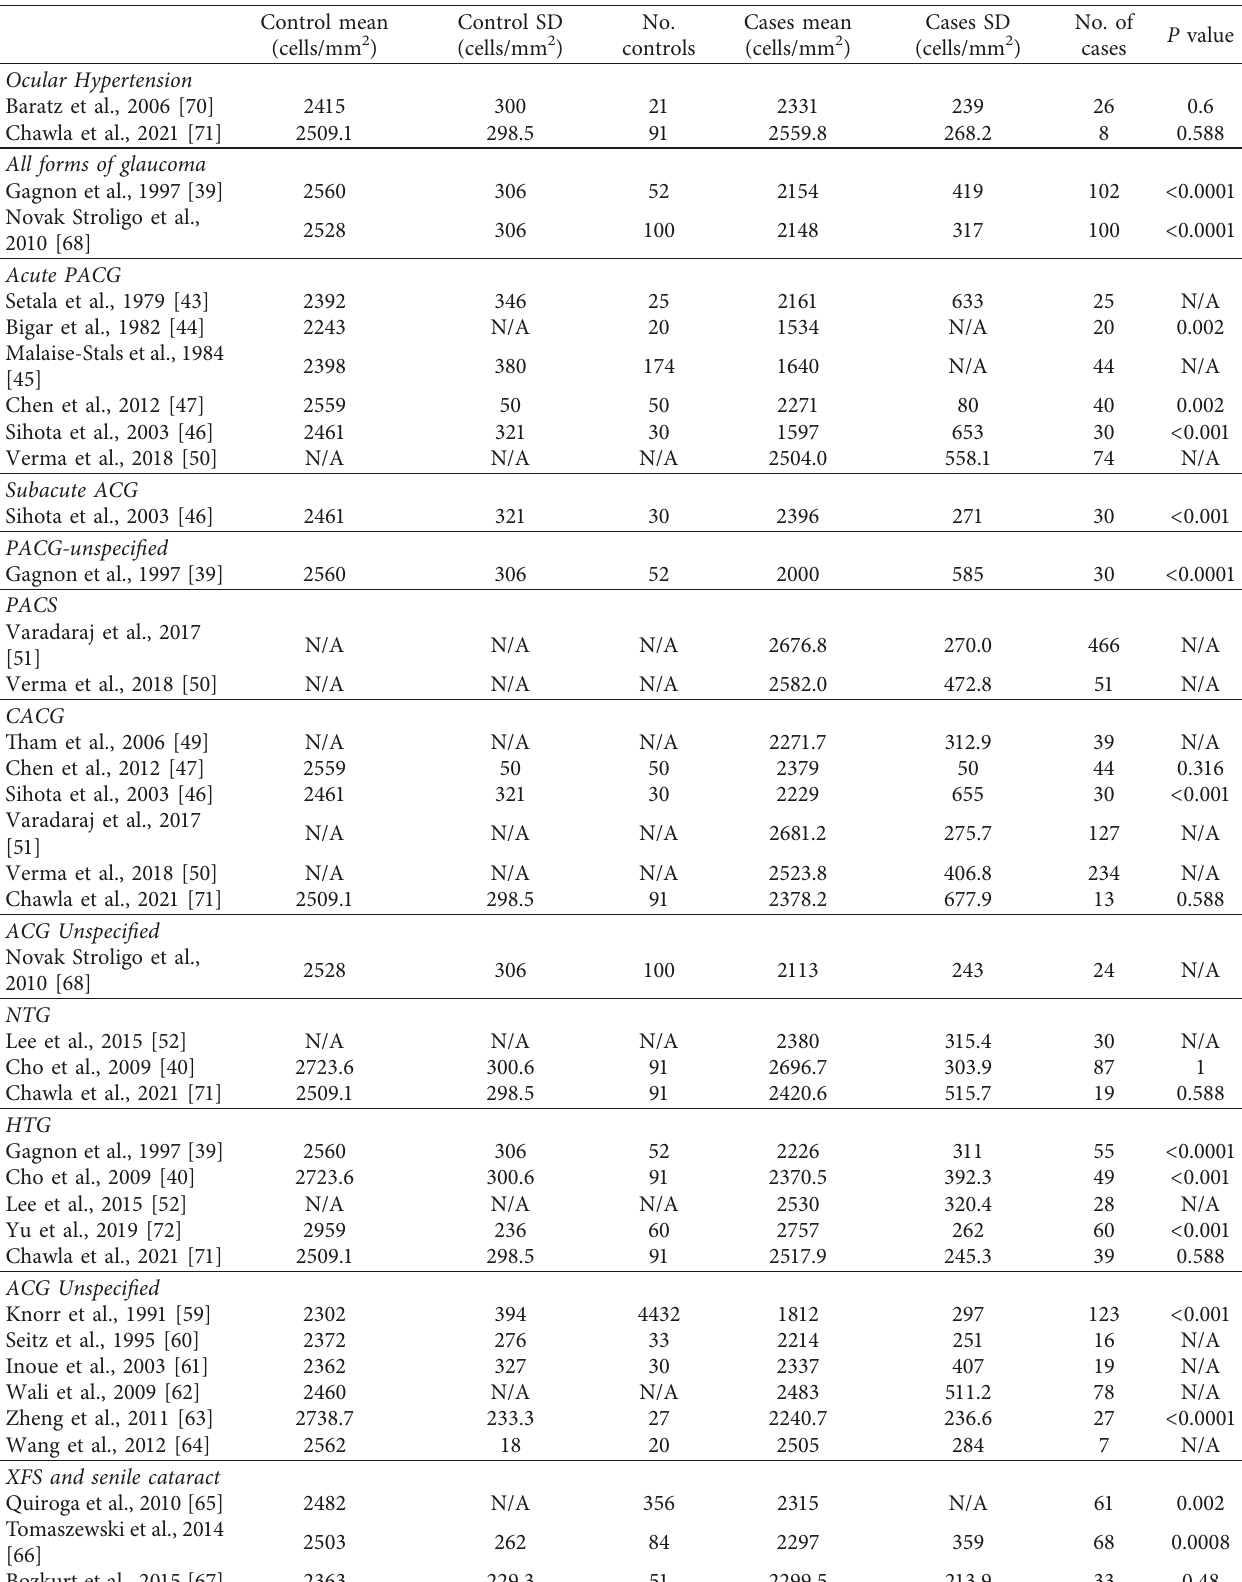
Table 1: Corneal endothelial densities in different forms of